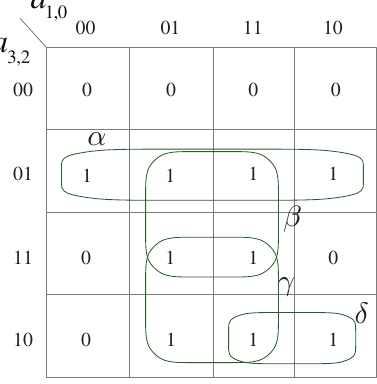
FIG. 17. A Karnaugh map on four input variables. The 16 cells correspond to the corners of a dimension-four binary hypercube, each of which is associated with specific values of the input vari- ables. The input values can be read from the left of the row and the opt of the column the cell is in. Each cell contains the boolean function value for the input state of the cell. The greek letter labels have been added for the discussion but are not normally part of a Karnaugh map. The leftmost 1 under the label α is in a cell with input values 0100. Note that the column and row input values follow the sequence 00, 01, 11, 10, which has the property that visually adjacent cells differ in the value of only one input variable. We also consider the right-hand edge to be adjacent to the left-hand edge and the bottom edge to be adjacent to the top